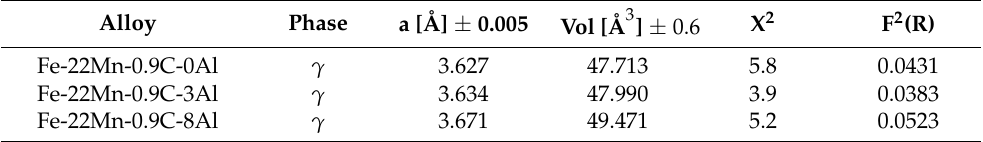
Figure 7. The XRD patterns of various Fe-22Mn-xAl-0.9C with x equal to 0, 3, 8 wt%. Table 4. Values of the Rietveld refinement parameters where a is the lattice parameter, Vol is the crystal volume, X 2 is the chi square, and F 2 (R) is the difference between the theoretical and experimental